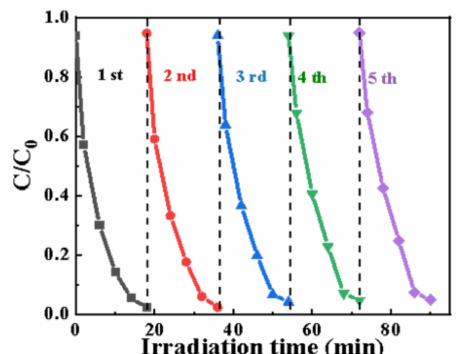
Figure 5. The cycling experiments of photocatalytic degradation of MBT by CN-AA-0.05